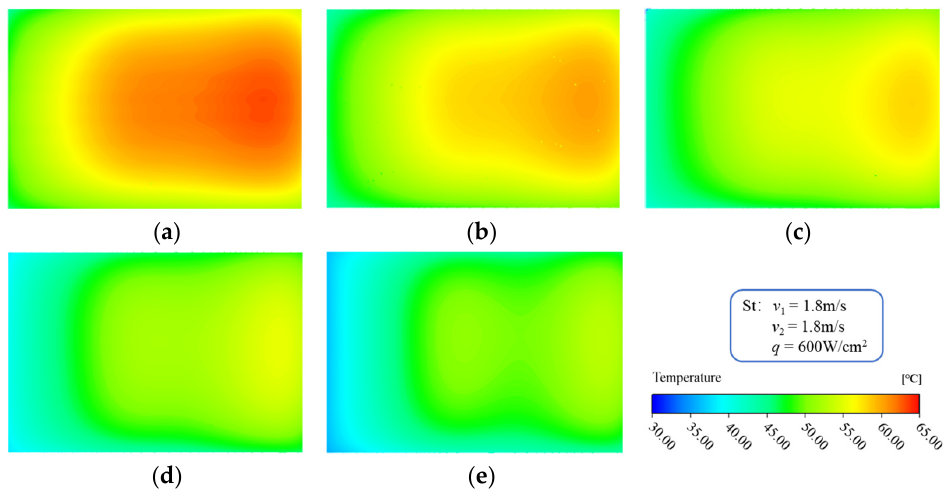
Figure 15. The temperature distribution of heating surface at different microchannel number. ( a ) N